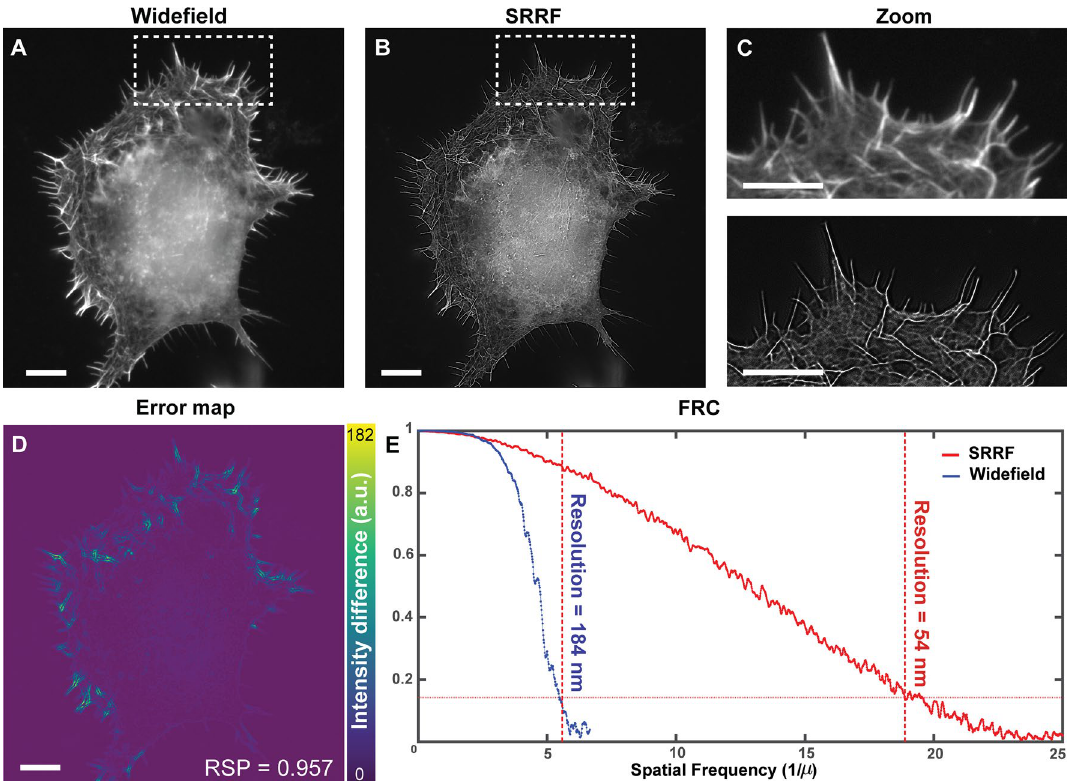
( D ) SQUIRREL analysis highlighting artifacts of SRRF reconstructions. ( E ) Resolution estimation using FRC curves for acquired widefield and SRRF images. Scale bar: 10